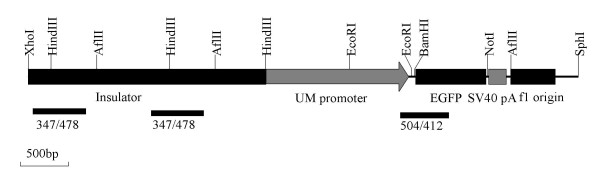
Schematic drawing of the pING32 transgene, excised from pING32 by digestion with XhoI-SphI. The lower bars indicate the lengths of the PCR products and the primer pairs used for the screening of the transgenic mice.